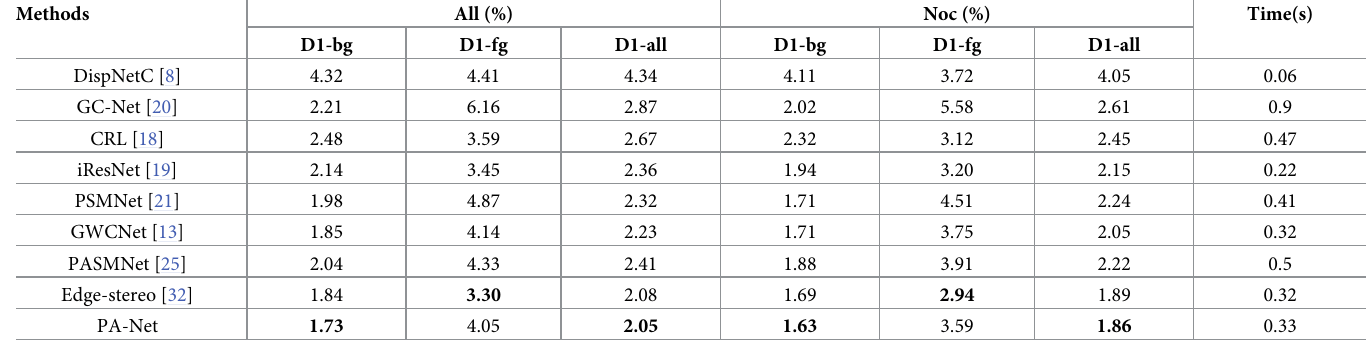
Table 3. Performance comparison of KITTI 2015 [10] test set. The GWC-Net [13] and PSM-Net [21] are trained with the same batch size as our method for fair comparison. Methods